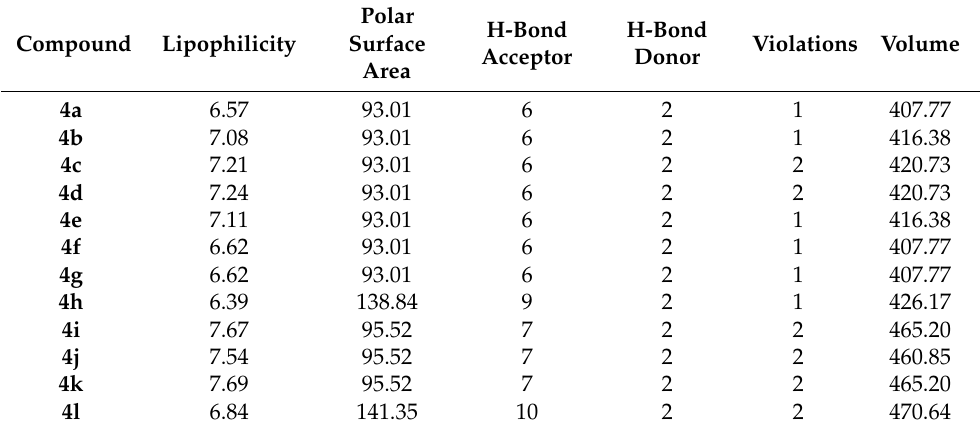
Table 7. Lipophilicity, total polar surface area, H-bond acceptor, H-bond donor, violations, and volume of compounds